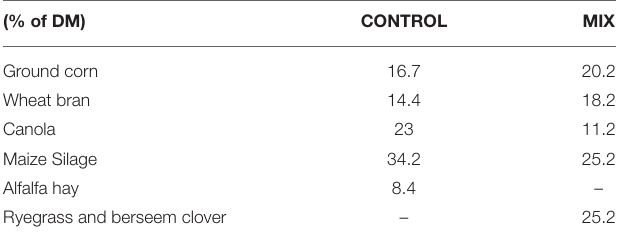
TABLE 1 | Configuration [% of dry matter (DM) basis] of the control (CONTROL) and experimental (MIX) diets offered to the cows during the experiment [adapted from (25)].